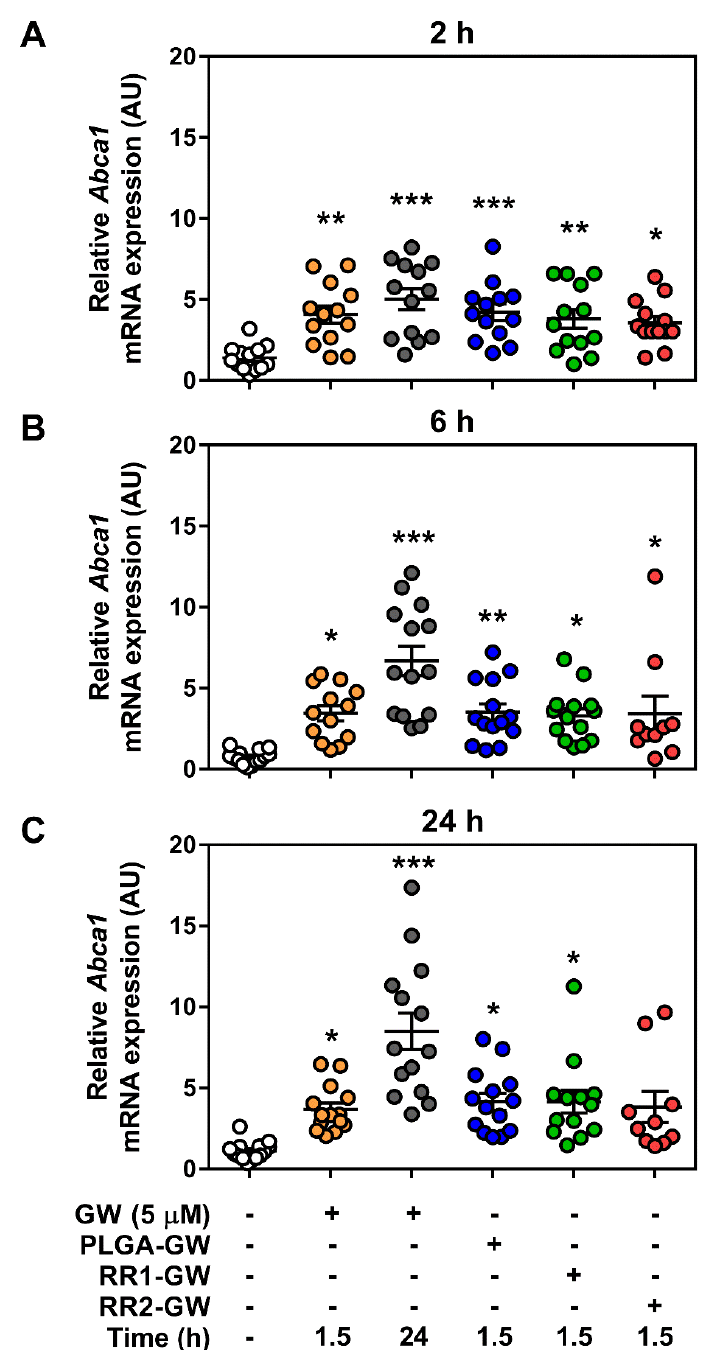
Figure 4. Liver X receptor (LXR) target mRNA expression is unchanged by GW-NP addition. WT BMDM were treated with nanoparticles encapsulating 5 µM GW-3965 for 1.5 h. Abca1 mRNA expression was measured in samples ( A ) 2 h, ( B ) 6 h, or ( C ) 24 h post-GW-NP treatment by RT-qPCR. Data represent mean ± SEM where *** p < 0.001, ** p < 0.01, and * p < 0.05 are di ff erences compared with vehicle control determined by one-way ANOVA ( n =